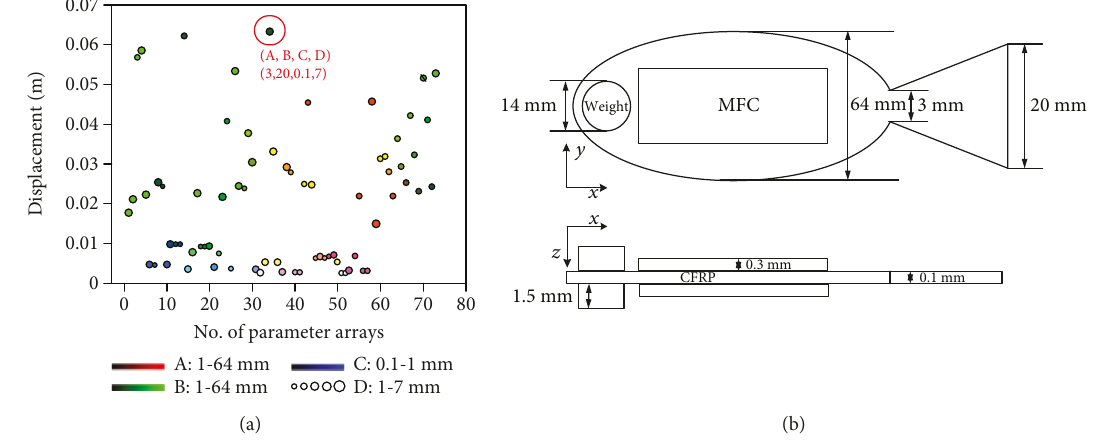
Figure 6: Model of the soft robot. (a) Displacement of caudal fi n end based on di ff erent parameter arrays. (b) New model of the soft robot. Table 3: Bending mode frequencies of the new soft robot in the fl uid.